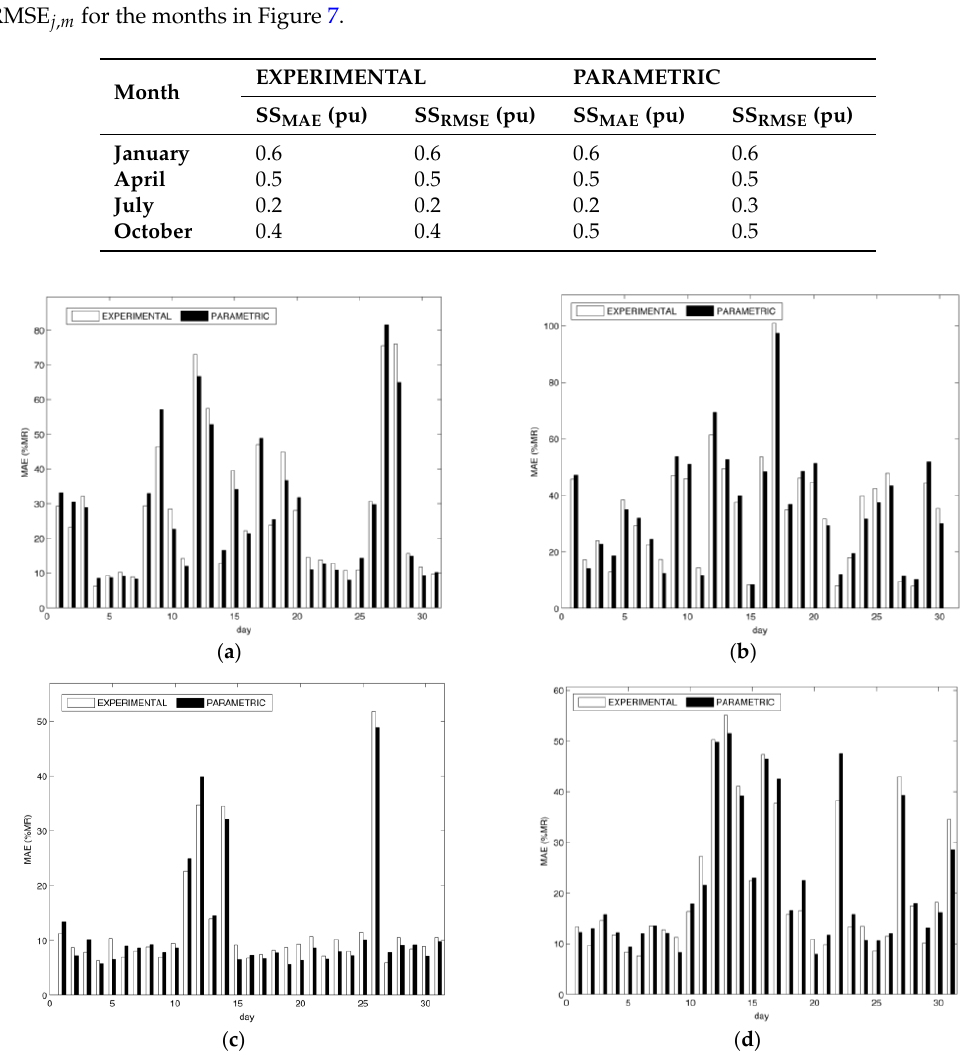
Figure 7. MAE j,m values versus the day of the month for the two different forecast methods: EXPERIMENTAL and PARAMETRIC. ( a ) January, ( b ) April, ( c ) July, and ( d ) October. Table 4. Monthly mean values of MAE j,m , MBE j,m and of RMSE j,m for the months in Figure 7.